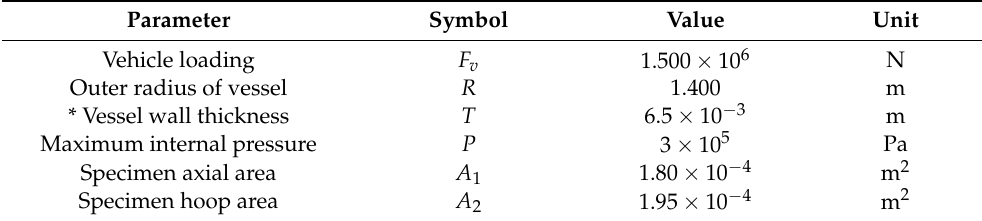
Table 1. Parameters used to determine the preload conditions used for the experimental testing. Parameter